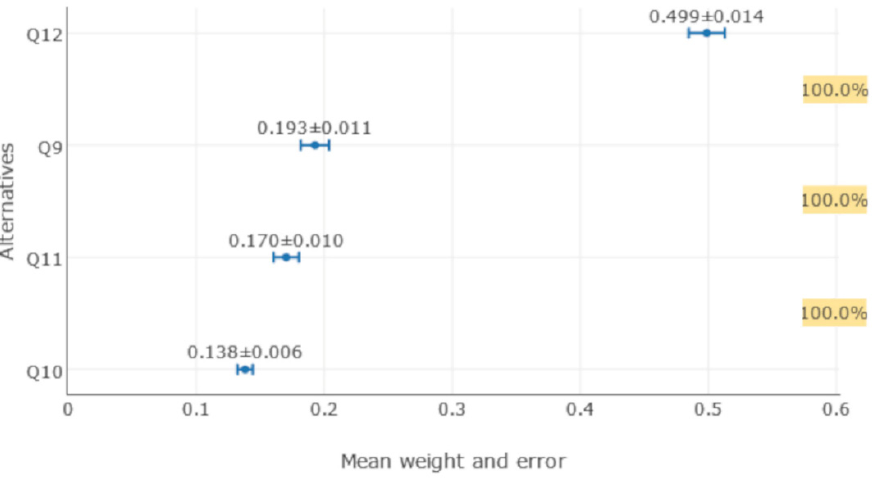
Figure 4. Alternatives (questions’ importance) comparison results with their mean weights, absolute errors, and ranking probabilities of compared alternatives Q9–Q12.